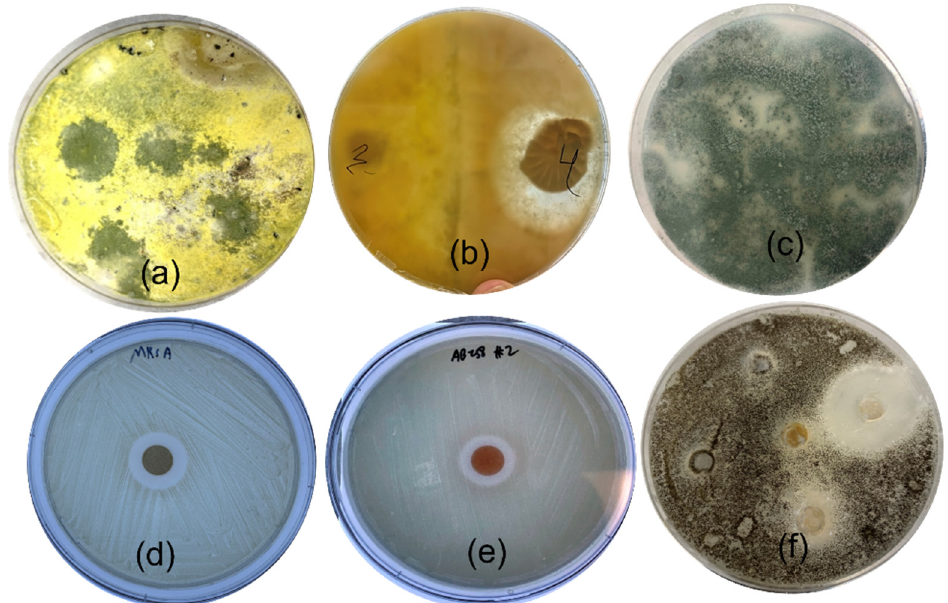
Figure 1. ( a ) Growth of fungi from soil samples on PDA plates; ( b ) inhibition of neighboring fungus by fungus S4; ( c ) monospore subculture of sample S4 fungus ( Aspergillus fumigatus ); ( d ) crude activity of the organic extract against MRSA; ( e ) crude activity of the organic extract against Acinetobacter baumannii AB258; ( f ) Antifungal activity of the crude extract against Aspergillus spp. Magnification is at 1 × ( no magnification ).